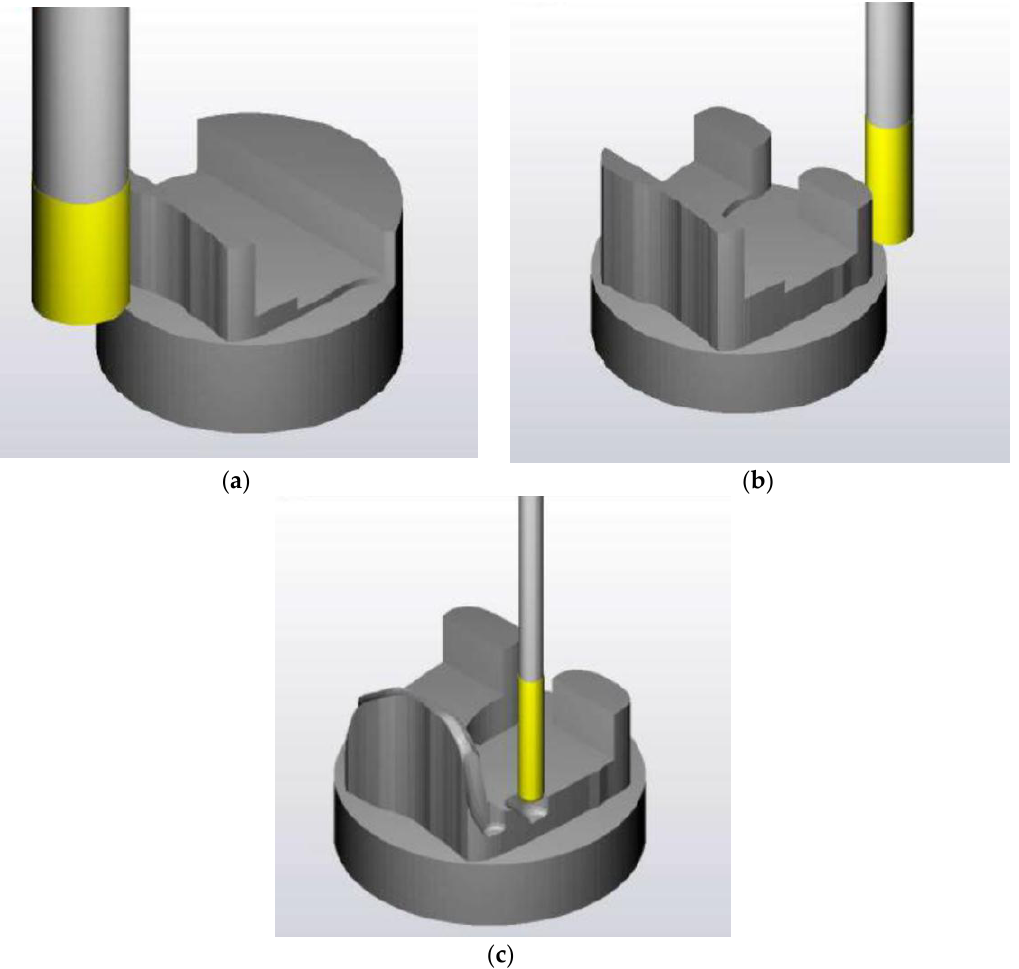
Figure 3. Snapshots from the simulation of the first machining stage: ( a ) Machining of the front surface of the femoral component using 16 mm diameter tool; ( b ) Machining of the back surface of the femoral component using 6 mm diameter tool; and, ( c ) Machining of inner surfaces of the femoral component using 4 mm ball end tool.